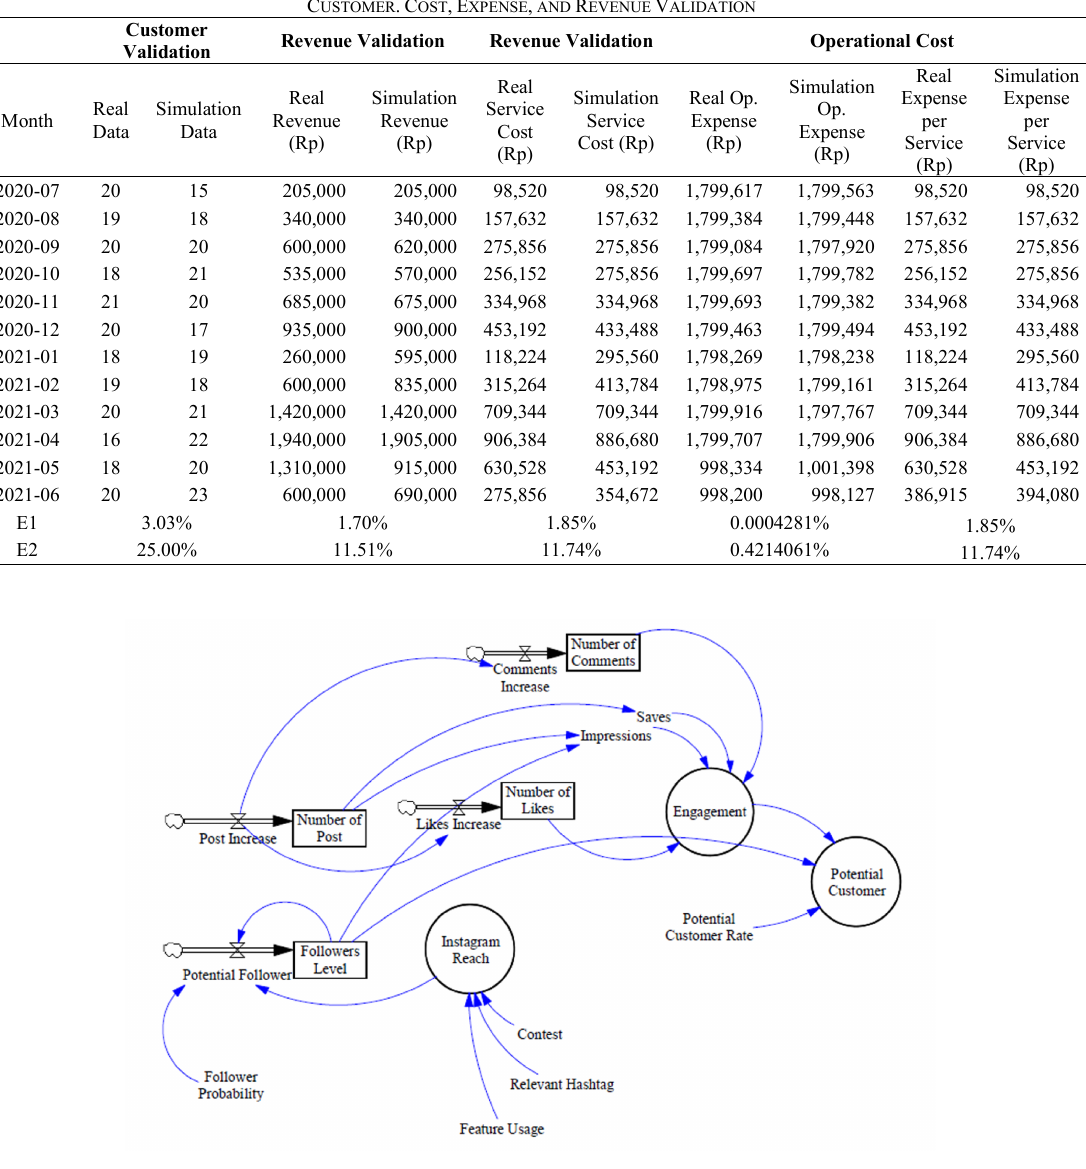
Fig. 4 Scenario Development IV. D